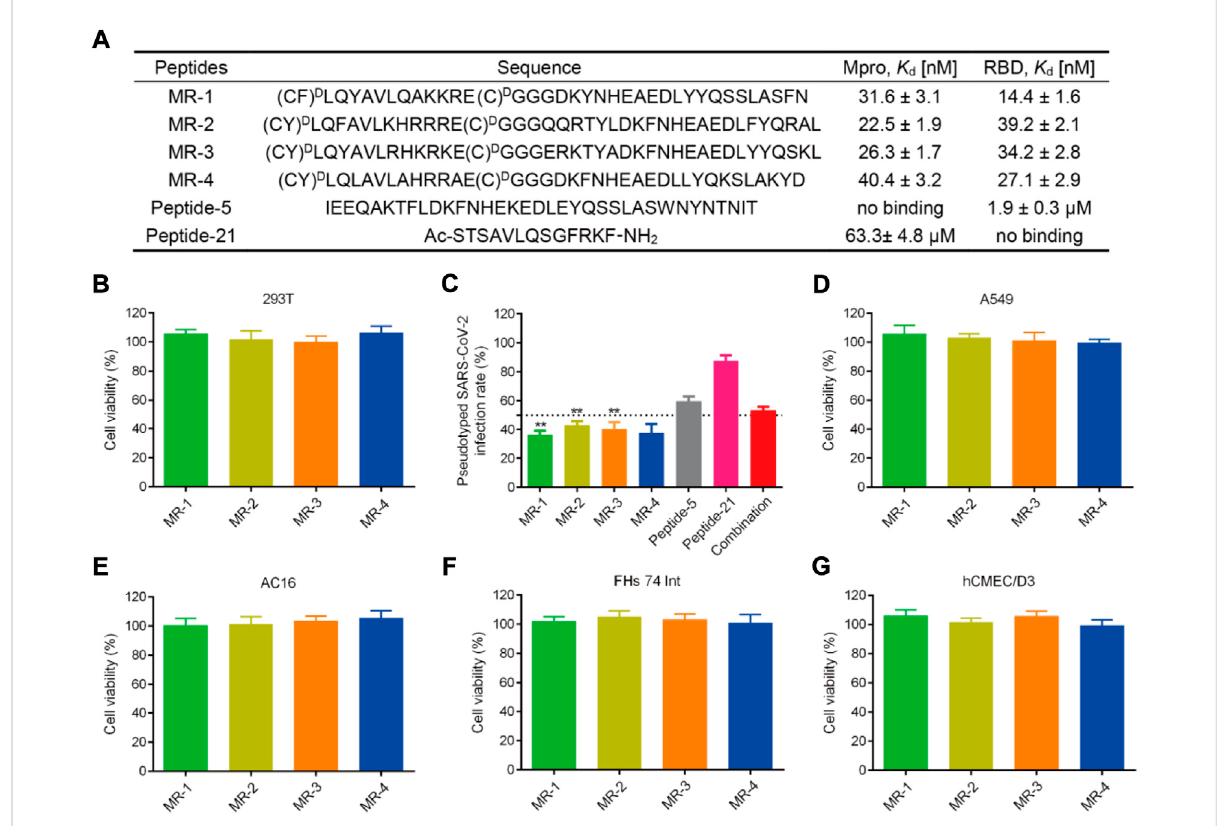
FIGURE 7 (A) Sequencesofthepeptidesandbindingaf fi nitiesofpeptidestotheMproandRBDproteins.MSTdatashownrepresentthemean±SD( n =3). Peptide-5 and Peptide-21 served as the positive controls. (B) Effects of MRs 1-4 on the viability of 293T cells. Cells were treated with peptides at a concentrationof50 μ Mfor48 h,MTTassaywasusedtodetectthecytotoxicityofpeptidestocells.Theresultsarerepresentedasmean±SD( n =3). (C) Infection rate of the pseudotyped SARS-CoV-2 virus. MRs 1-4, Peptide-5, Peptide-21, and the combination of Peptide-5 and Peptide-21 were tested at a concentration of 5 μ M, respectively. ** p < 0.01 means a signi fi cant difference versus Peptide-21. (D – G) Effects of MRs 1-4 on the viability of A549, AC16, FHs 74 Int and hCMEC/D3 cells. Cells were treated with 50 μ M of MRs 1-4 for 48 h, MTT assay was used to detect the cytotoxicity of peptides to cells. The results are represented as mean ± SD ( n =